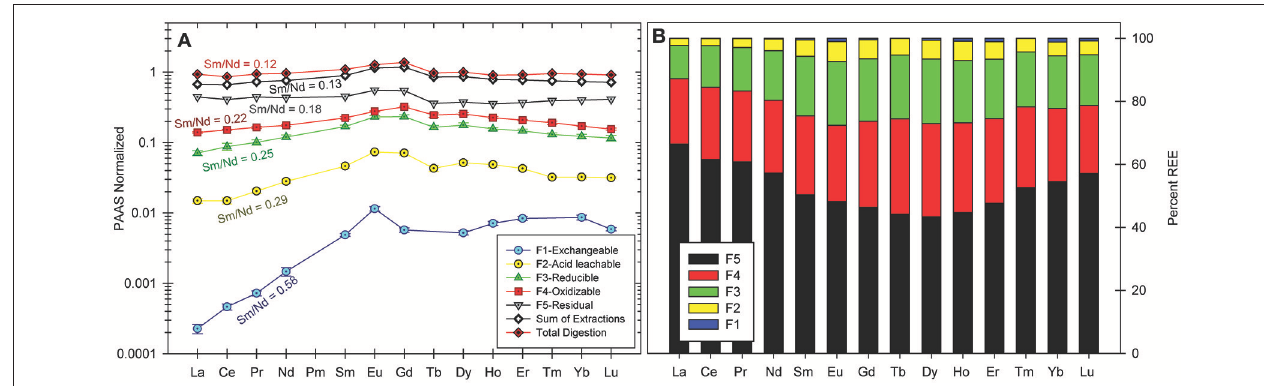
FIGURE 6 | (A) PAAS-normalized REE patterns of different operationally defined fractions from sequential extractions of Mississippi River sediment, and comparison of the sum of extractions to a single total digestion of sample aliquot. (B) Percentage distribution of the REE between the operationally defined